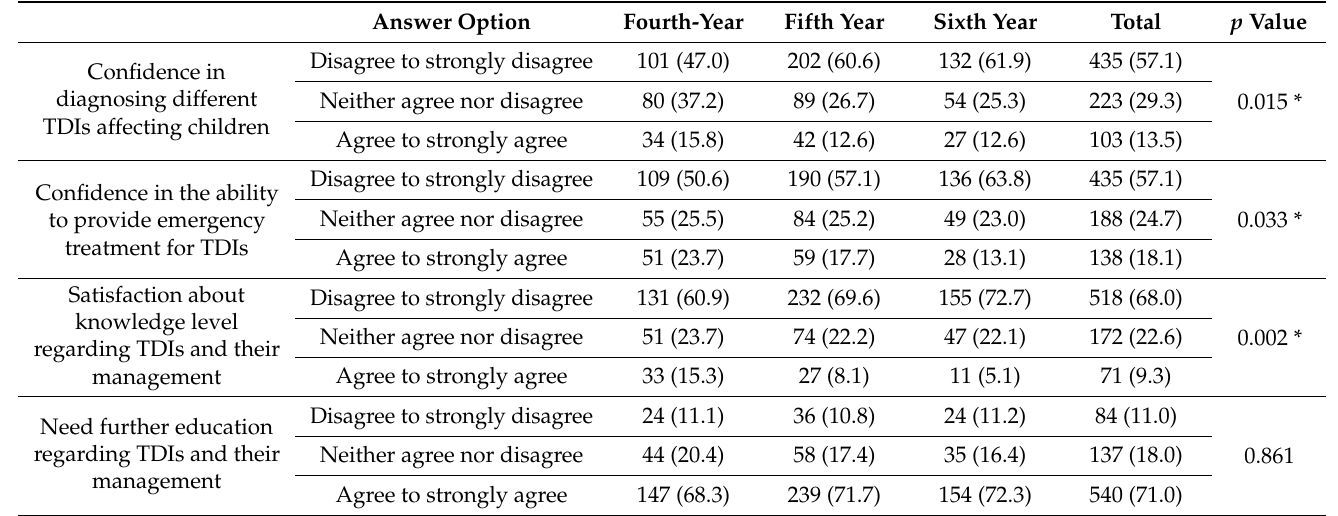
Table 5. The students’ attitudes about emergency management of traumatic dental injuries according to the academic level